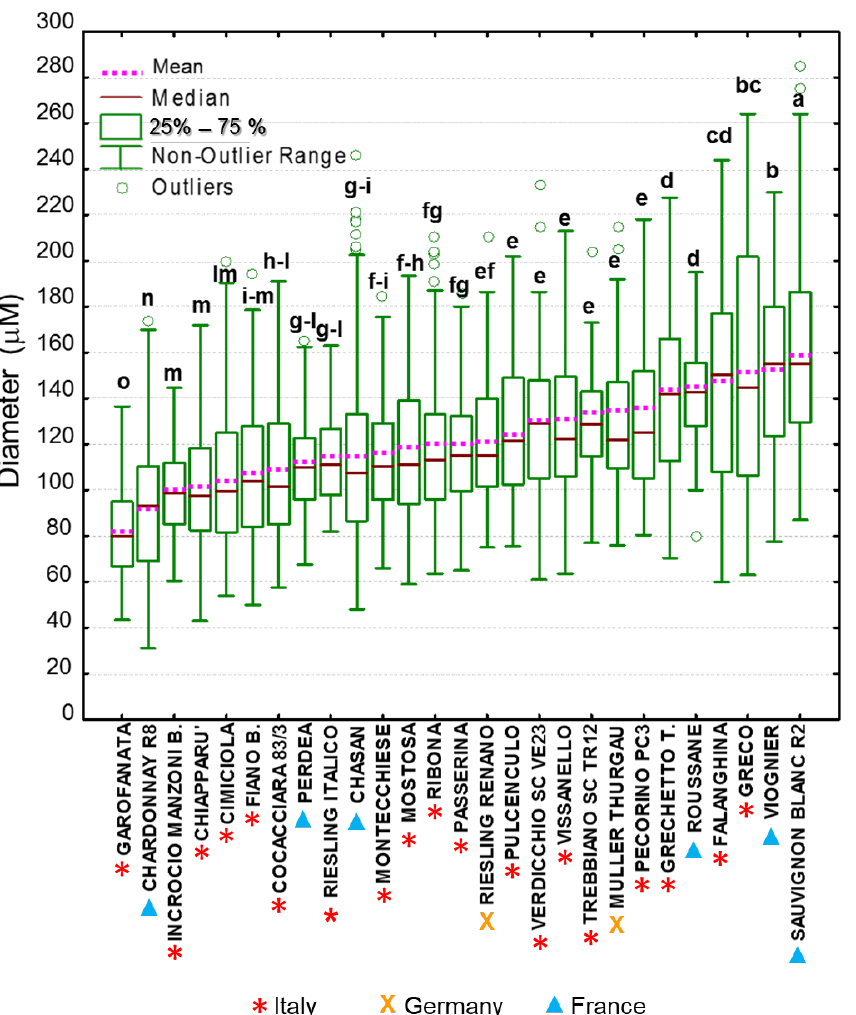
Figure 5. Box plot representing means of equivalent circle diameters measured in the 27 white- berried grapevine cultivars. The median and mean are represented by solid red and dotted pink lines, respectively. Top and bottom lines of the box correspond to the 25th and 75th percentiles of the data, respectively. Error bars represent the 10th and 90th percentiles. Circles represent outliers. Different letters above columns indicate significant differences between cultivars (Fisher’s tests; p ≤ 0.05). The geographic origin from Vitis International Variety Catalogue database (www.vivc.de) [39] was added.